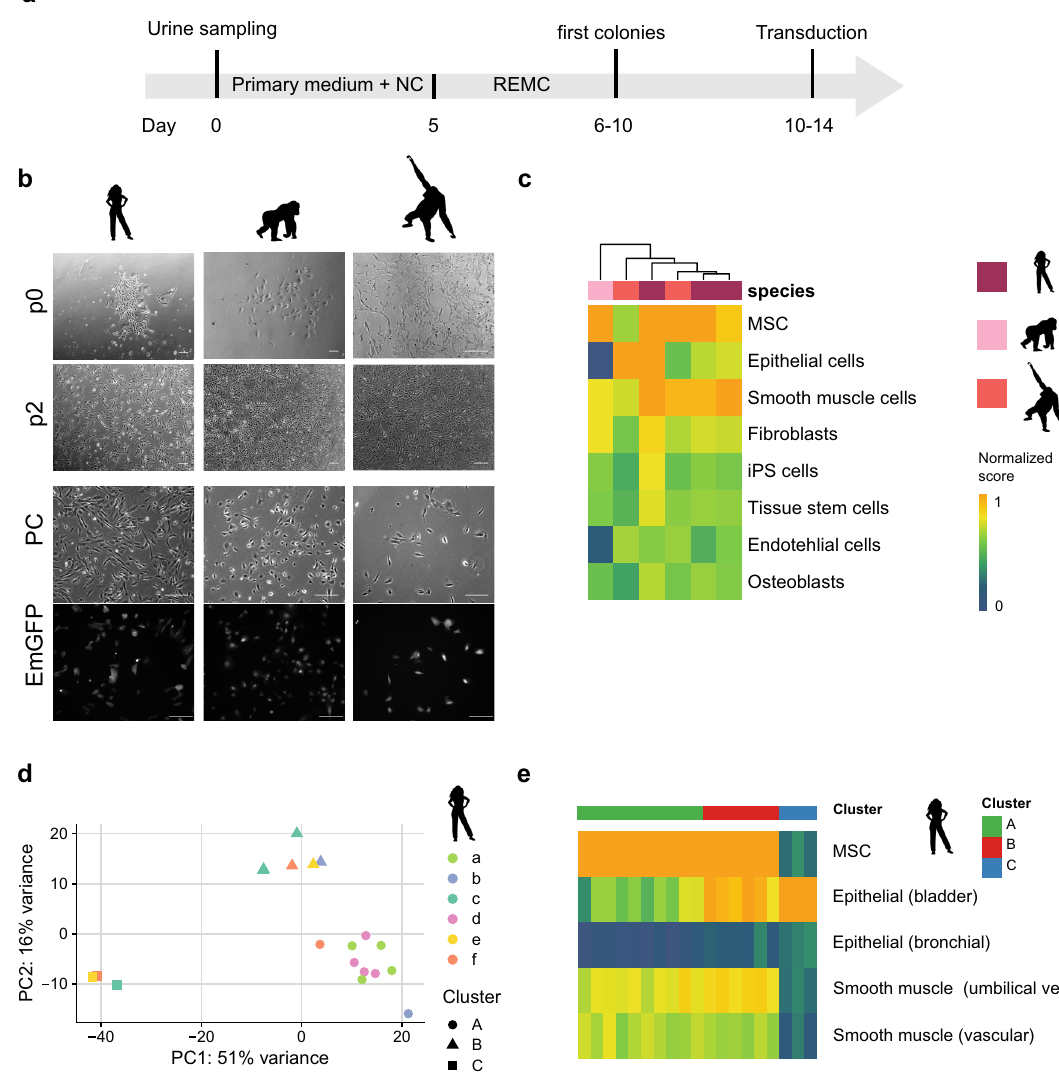
Figure 3. Isolation and characterization of primate urinary cells. ( a ) Workflow of cell isolation from primate urine samples. NC Normocure, REMC renal epithelial mesenchymal cell medium. ( b ) Primary cells obtained from human, gorilla and orangutan samples are morphologically indistinguishable and display similar EmGFP transduction levels. Scale bars represent 400 μm. ( c ) The package SingleR was used to correlate the expression profiles from six samples of primate urinary cells (passage 1–3) to a reference set of 38 human cell types. Normalized scores of the eight cell types with the highest correlations are shown ( MSC mesenchymal stem cells, SM smooth muscle, Epi epithelial, Endo endothelial). Color bar indicates normalized correlation score. ( d ) Principal component analysis of primary cells from single colony lysates using the 500 most variable genes. ( e ) Heatmap of normalized SingleR scores show that cluster C is classified as epithelial cell originating from the bladder. The scores for MSCs in Cluster A and B are similarly high, although cluster B also shows higher scores for epithelial cells than cluster A. See also Supplementary Figure